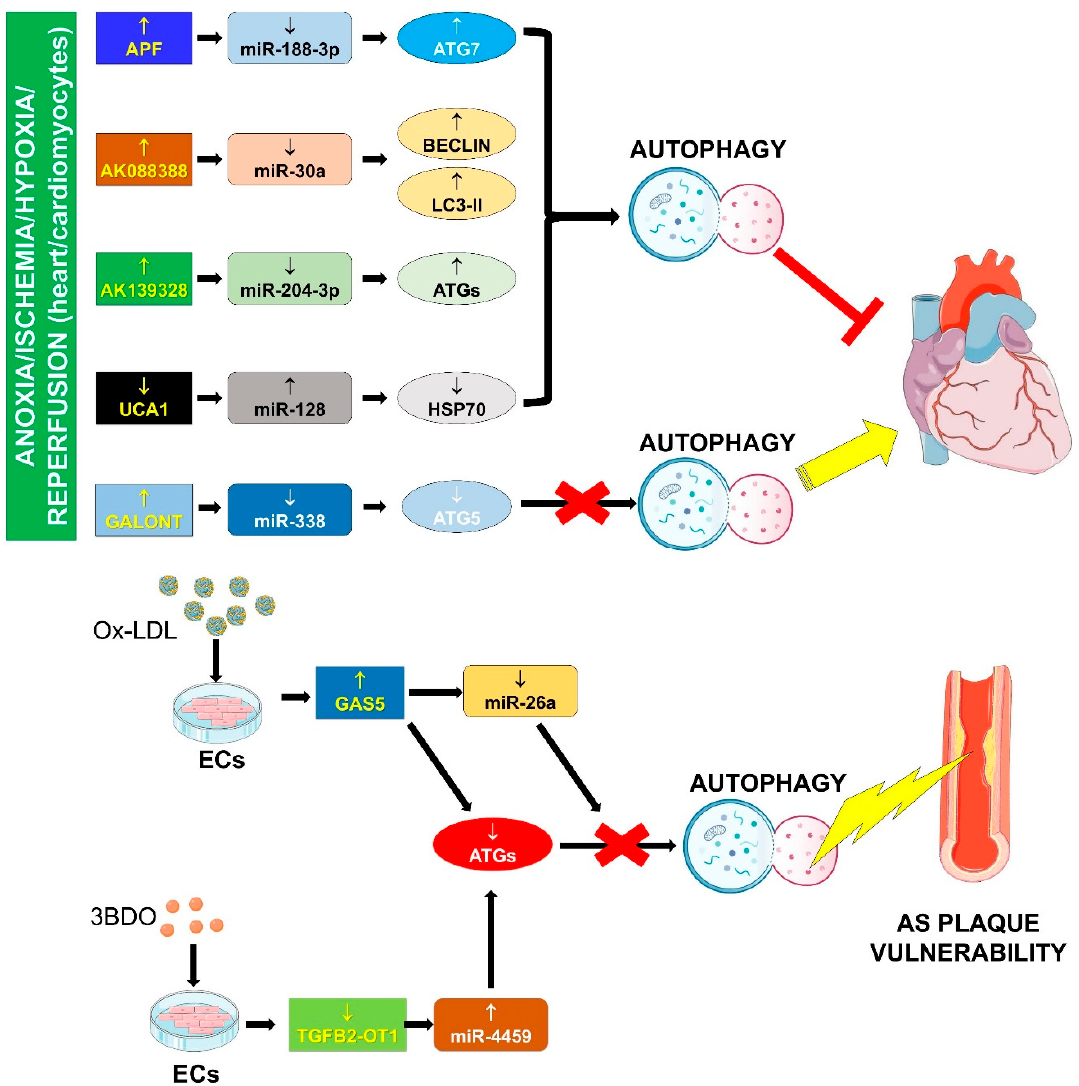
Figure 3. LncRNA-miRNA-mRNA networks and autophagy. A decrease in autophagic function is a hallmark of ageing. A variety of stimuli, such as hypoxia or ischemia/reperfusion, oxidized lipoproteins (ox-LDL) or treatment with an MTOR pathway agonist (3BDO), can activate the interaction of lncRNA and miRNA, and the specific modulation of direct and/or indirect targets that, in turn, can affect positively or negatively the autophagic process.